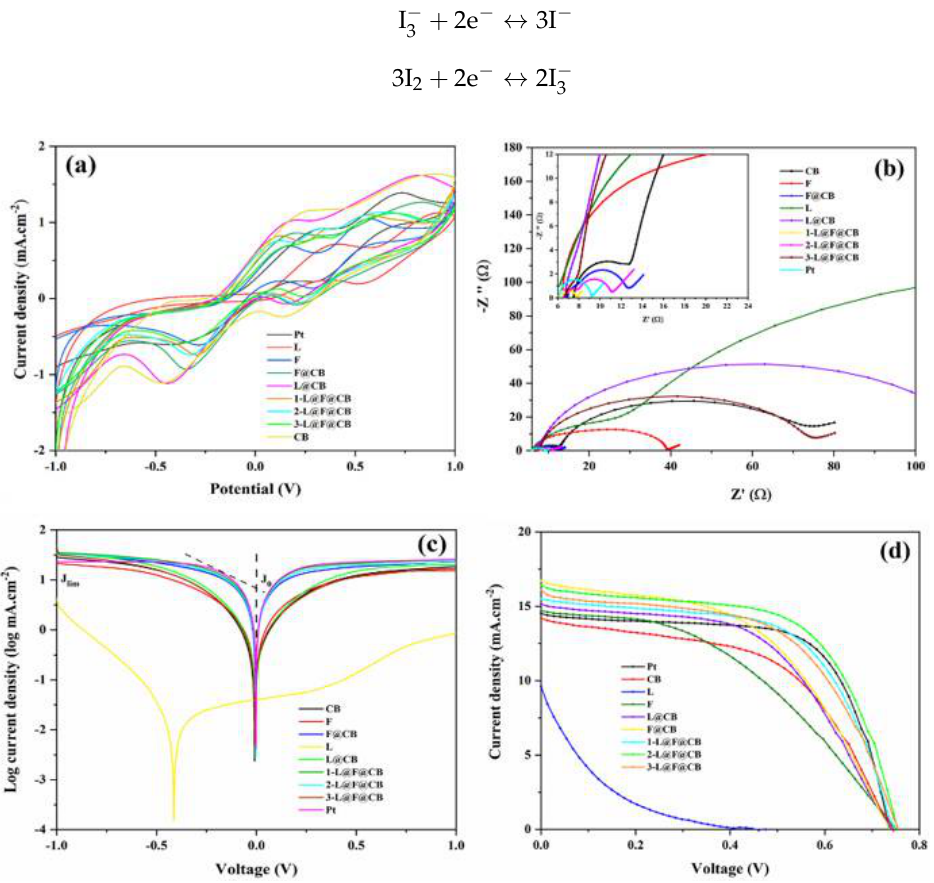
Figure 4. CV plots of various CEs at 50 mV.s − 1 ( a ); EIS Nyquist plots ( b ); Tafel polarization plots ( c ); J–V plots of DSSCs using Pt, CB, L, F, L@CB, F@CB, 1-L@F@CB, 2-L@F@CB, and 3-L@F@CB based CEs ( d ).